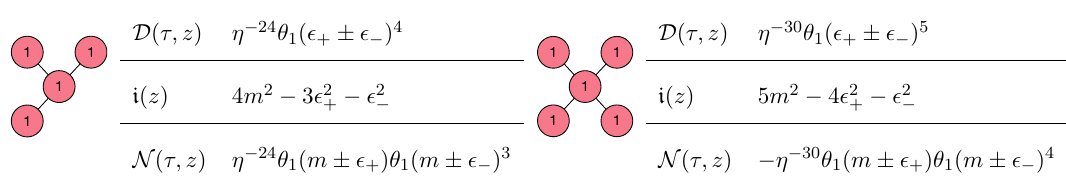
Table 4 . Elliptic genera of (2 ; 0) string chains determined from I 0